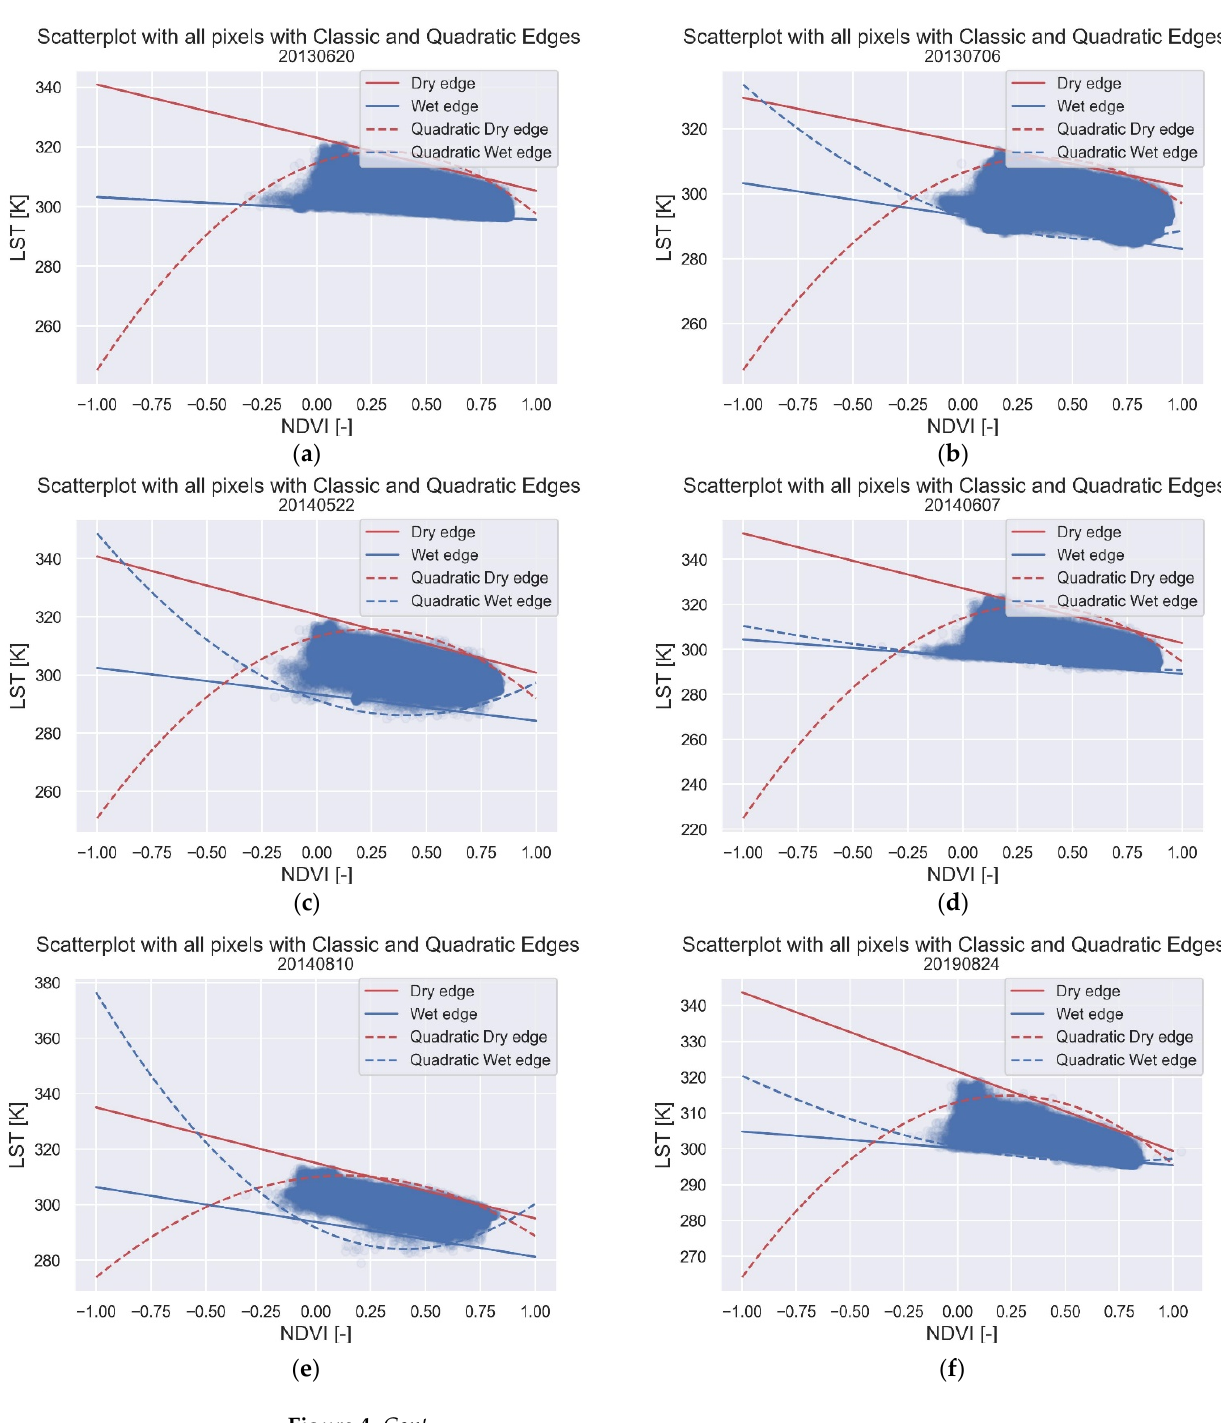
( h ) ( i ) Figure 4. LST ‐ NDVI scatter plots with dry and wet edges with all pixels plotted for all analyzed dates:( a ) 20 June 2013, ( b ) 6 July 2013, ( c ) 22 May 2014, ( d ) 7 June 2014, ( e ) 10 August 2014, ( f ) 24 August 2019, ( g ) 22 May 2020, ( h ) 25 July 2020, ( i ) 10 August 2020. 3.3. Spatial Distributions of Studied Satelite Indices over the Studied Area Figure 5 shows exemplary spatial distributions of all studied satellite indices over the research area on 10 August 2020. It can be seen in Figure 5 that higher TVDI and qTVDI values correspond to higher LST and NDBI values and lower NDVI values. It is generally true for all dates of the study. The figures for other data are available for additional mate ‐ rials attached to the paper. Figure 4 also shows that near the city center and other densely